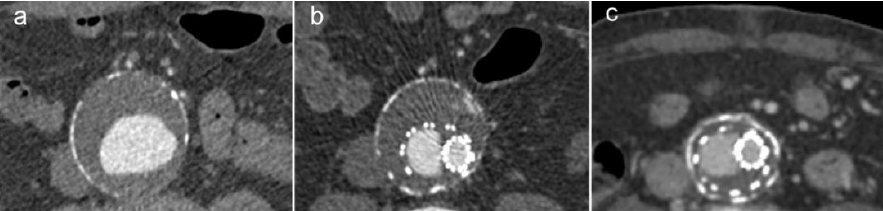
Figure 2. ( a ) CT angiogram showing an infrarenal abdominal aortic aneurysm. The patient under- went EVAR with follow-up CT 1 year ( b ) and 16 years ( c ) post-procedure. Note the reduction in sac size over time.